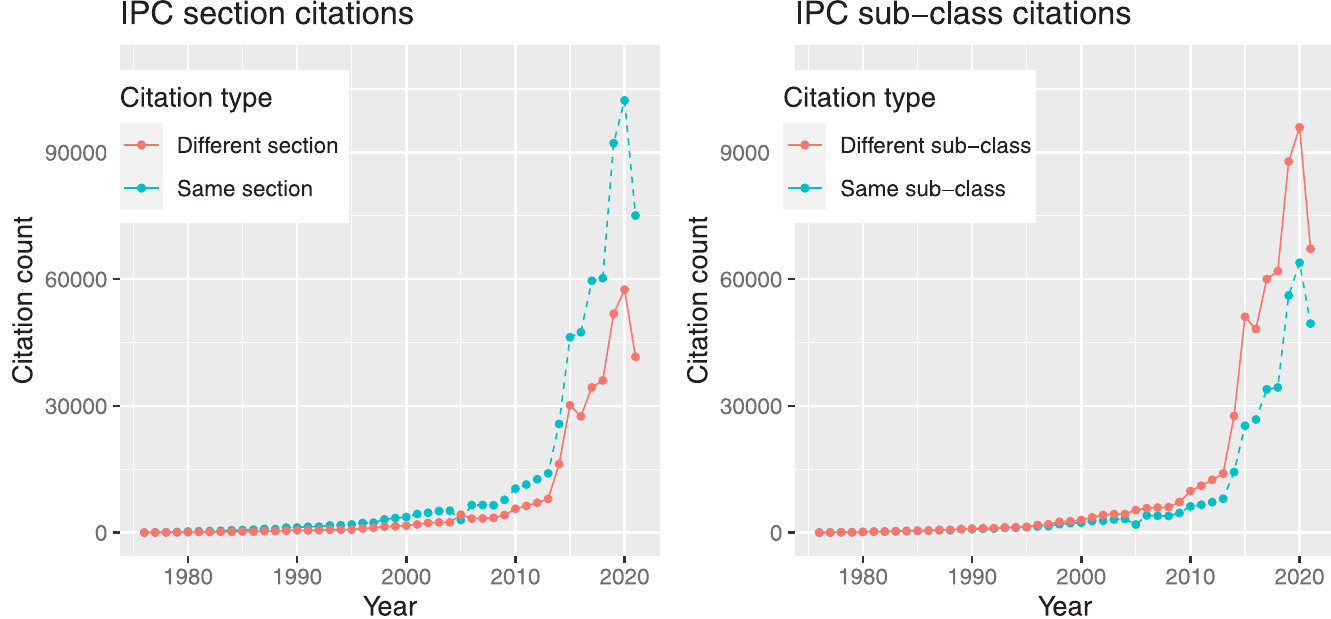
Fig 1. IPC citations comparison. Amount of citations within the same class (left) and sub-class (right) during the observation period.